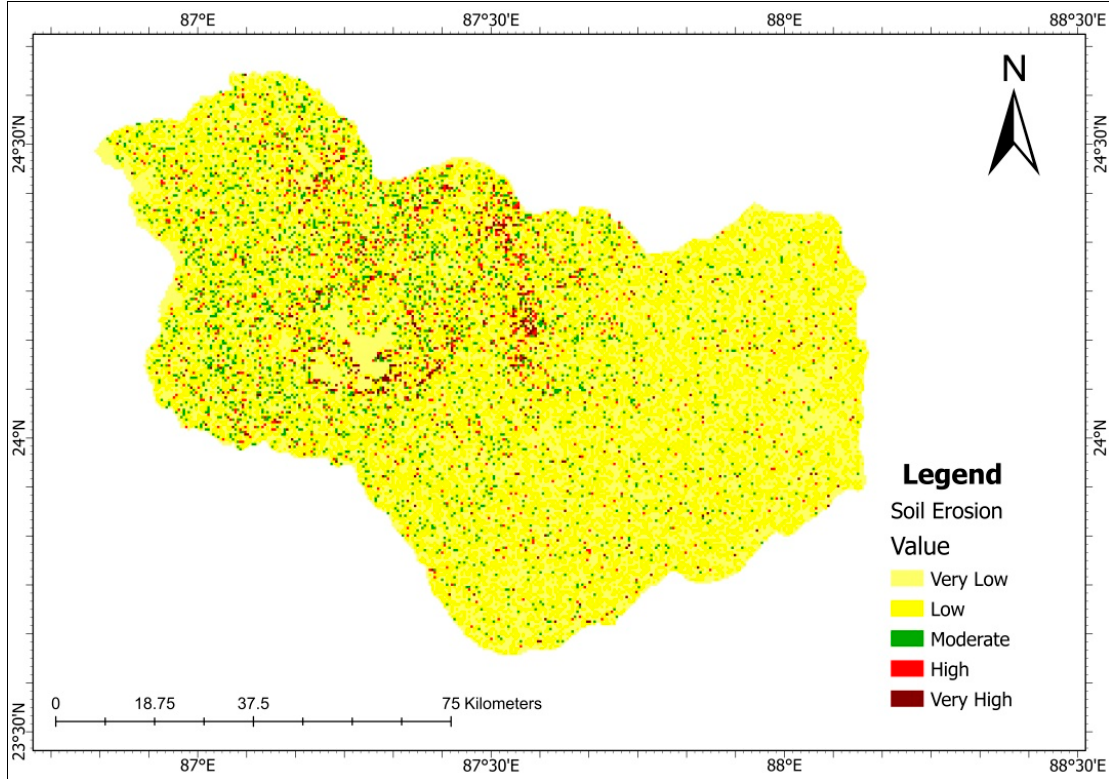
Figure 12. Soil erosion probability map.